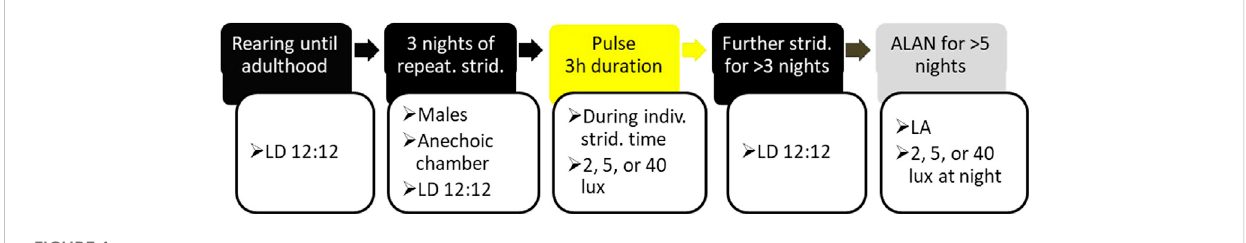
FIGURE 1 The experimental timeline: Adult, male crickets reared under LD 12:12 illumination regime (see Materials and Methods for details) were placed individually, eachinan anechoic chamber,and their stridulation and locomotion monitored simultaneously(two leftblackboxes).On thenightfollowing three consecutive nights of consistent stridulation behavior, the experimental crickets were exposed to a light pulse (yellow box) of the duration of three hours and an intensity of 2, 5, or 40 lux. Following three to fi ve additional nights under LD regime (right black box), the experimental animals were subjected to 12 h light:12 h ALAN (LA) or constant light (LL) conditions for at least fi ve consecutive days and nights (grey